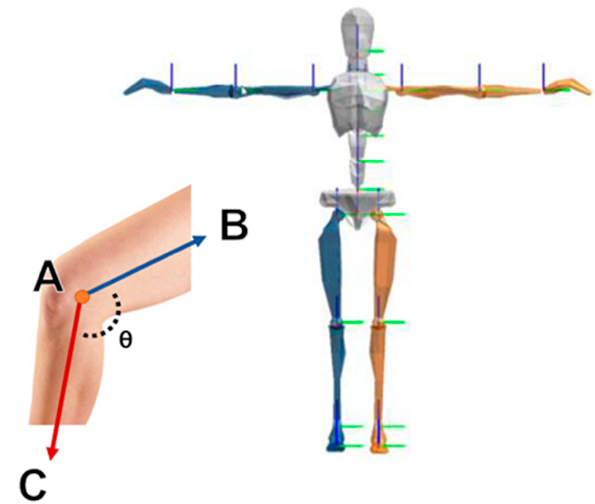
Figure 2. The vectors on ankle joints.